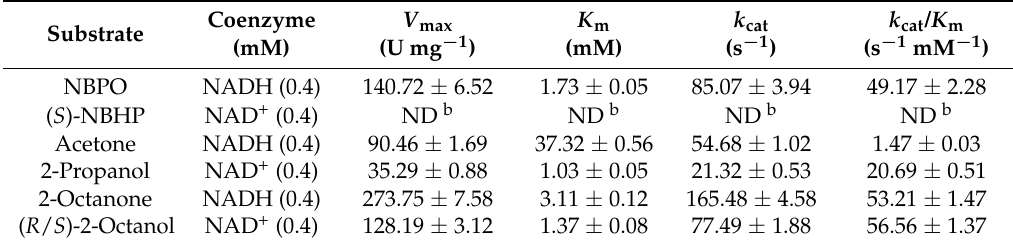
Table 3. Kinetic parameters of ReCR variant Y54F a.